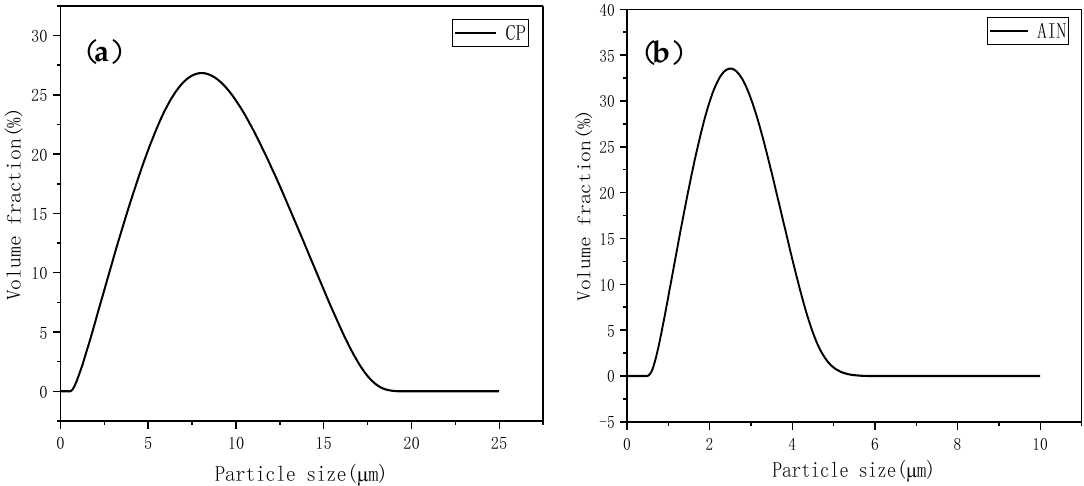
Figure 2. Particle size distribution diagram. ( a ) CP. ( b ) AIN.